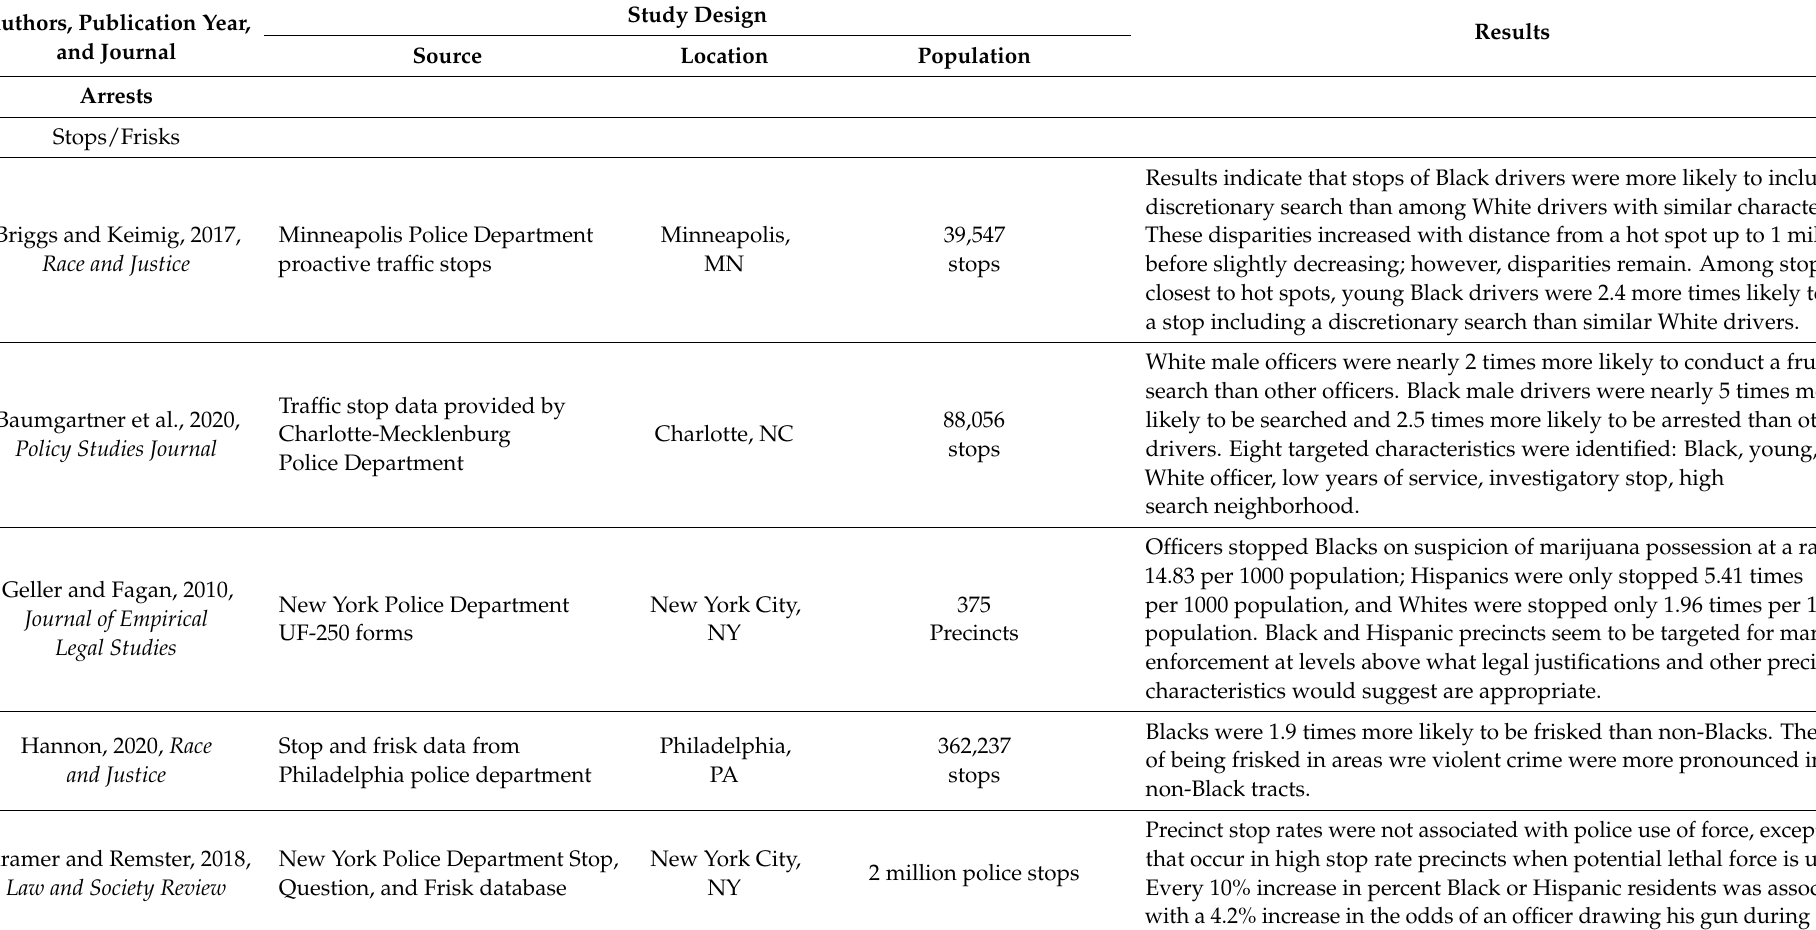
Results indicate that stops of Black drivers were more likely to include a discretionary search than among White drivers with similar characteristics. These disparities increased with distance from a hot spot up to 1 mile, before slightly decreasing; however, disparities remain. Among stops closest to hot spots, young Black drivers were 2.4 more times likely to have a stop including a discretionary search than similar White drivers. White male officers were nearly 2 times more likely to conduct a fruitless search than other officers. Black male drivers were nearly 5 times more likely to be searched and 2.5 times more likely to be arrested than other drivers. Eight targeted characteristics were identified: Black, young, male, White officer, low years of service, investigatory stop, high search neighborhood. Officers stopped Blacks on suspicion of marijuana possession at a rate of 14.83 per 1000 population; Hispanics were only stopped 5.41 times per 1000 population, and Whites were stopped only 1.96 times per 1000 population. Black and Hispanic precincts seem to be targeted for marijuana enforcement at levels above what legal justifications and other precinct characteristics would suggest are appropriate. Blacks were 1.9 times more likely to be frisked than non-Blacks. The odds of being frisked in areas wre violent crime were more pronounced in non-Black tracts. Precinct stop rates were not associated with police use of force, except stops that occur in high stop rate precincts when potential lethal force is used. Every 10% increase in percent Black or Hispanic residents was associated with a 4.2% increase in the odds of an officer drawing his gun during a